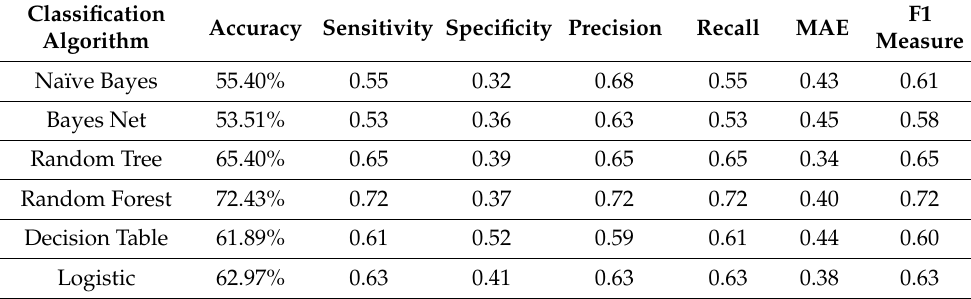
Table 9. Hybrid Feature Fusion on